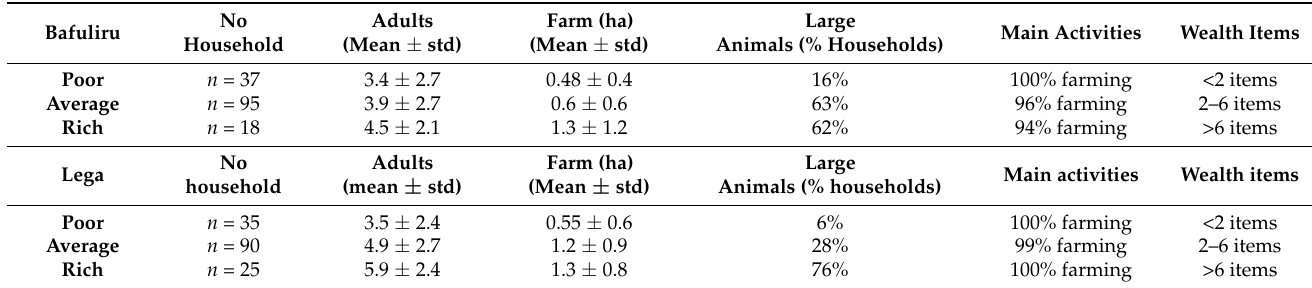
Table 1. Wealth analysis of the two ethnic groups ( n = 150 Bafuliru, n = 150